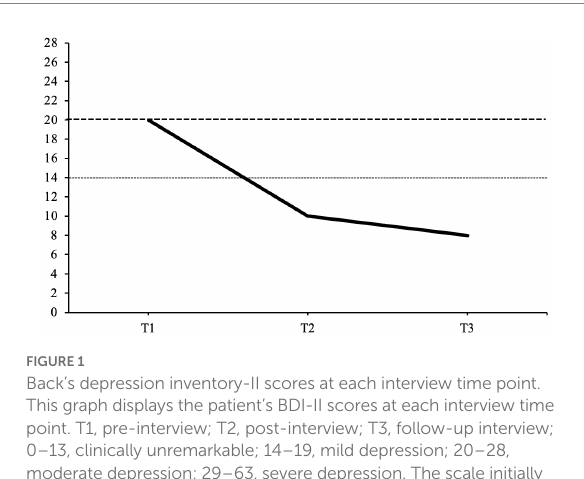
FIGURE 2 OPD-SQS domain scores at each interview time point. This graph illustrates the patient’s OPD-SQS scores for the domains self- perception, contact design and relationship model at each interview time point. T1, pre-interview; T2, post-interview; T3, follow-up